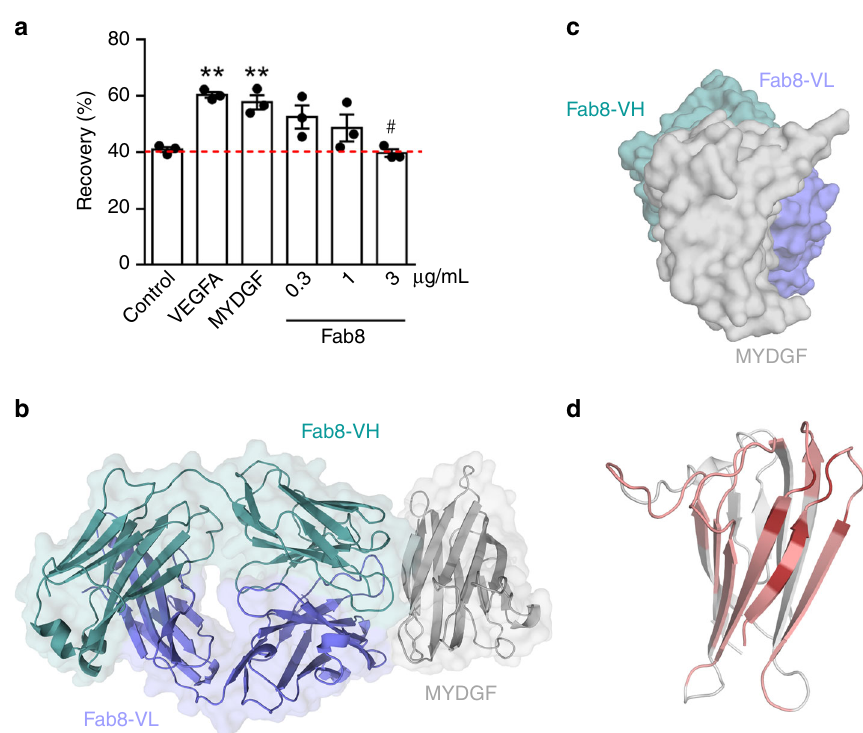
Fig. 2 Endothelial cell migration assay and crystal structure of MYDGF-Fab8 complex. a Migration assay quantifying HCAEC monolayer recovery 16 h after scratch injury in the absence (control) or presence of vascular endothelial growth factor A (VEGFA, 50 ng/ml) or wild-type MYDGF (100 ng/ml) in the absence or presence of control IgG (10 µ g/ml), or Fab8 (at indicated concentrations). Fab8 shows neutralizing effects. ** P < 0.01 vs. control; # P < 0.05 vs. MYDGF + IgG; n = 3; one-way ANOVA + Dunnett's; SEM error bars. Supplementary Fig. 11 shows the endothelial cell migration assay using Ab8. b Cartoon and surface representation of MYDGF (gray) and neutralizing Fab8 variable light (blue) and variable heavy chain (turquois). c Asymmetrical binding of Fab8 to MYDGF sterically blocks a large area on MYDGF top and front face for binding of the unknown receptor (same color coding as above). d The MYDGF-Fab8 epitope is colored in dark red. All residues, which are possibly shielded by the Fab8 and therefore not accessible for receptor recognition, are colored in